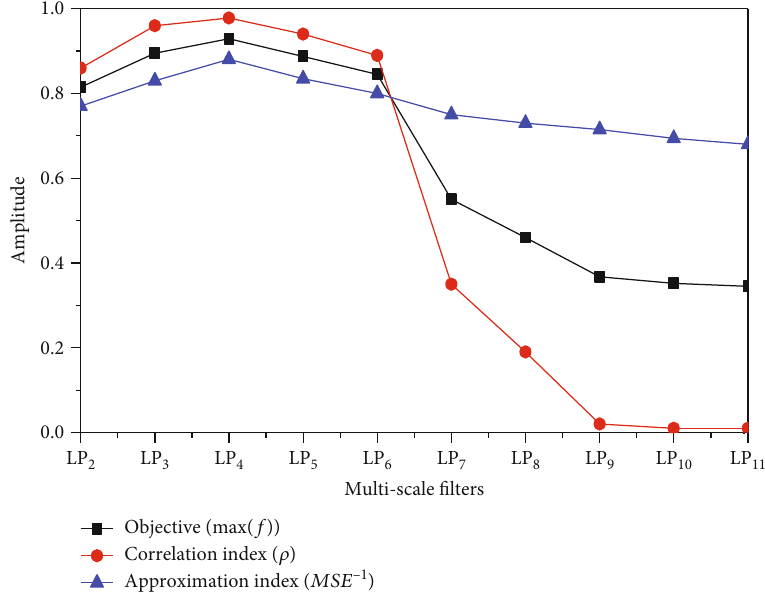
Figure 13: Variation trends of the index MSE − 1 , ρ , and max f f g